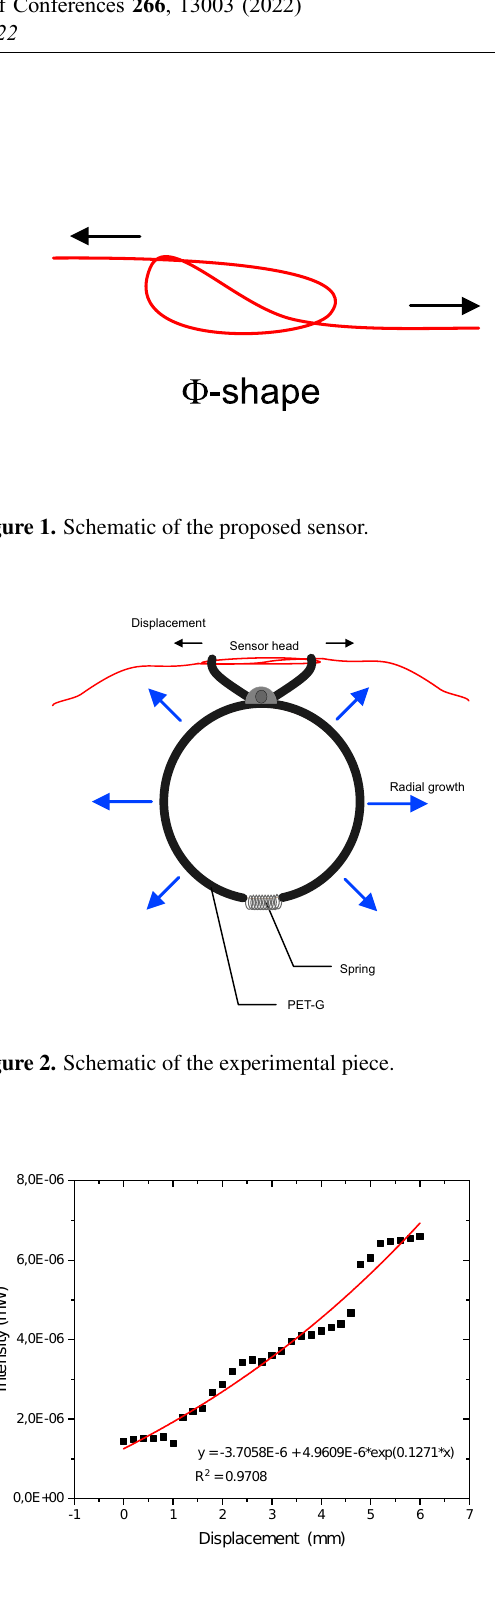
Figure 3. Gain intensity caused by the diameter